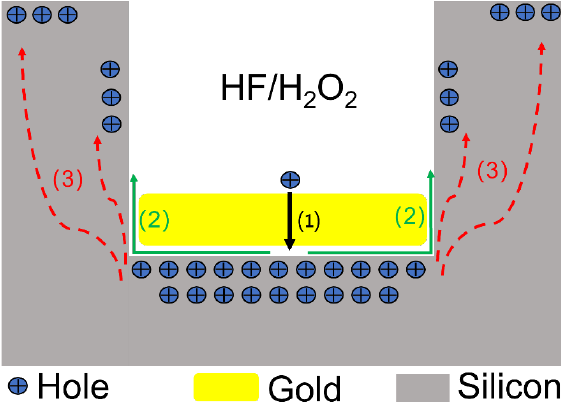
Figure 2. Schematic processes of metal-assisted chemical etching with gold. (1) The oxidant (H 2 O 2 ) is reduced, and the holes generate and inject into the silicon beneath the gold film. (2) The Si is oxidized by the injected holes and dissolved at the Si/Au interface by HF. (3) The off-metal areas are etched because of the excess hole diffusion.